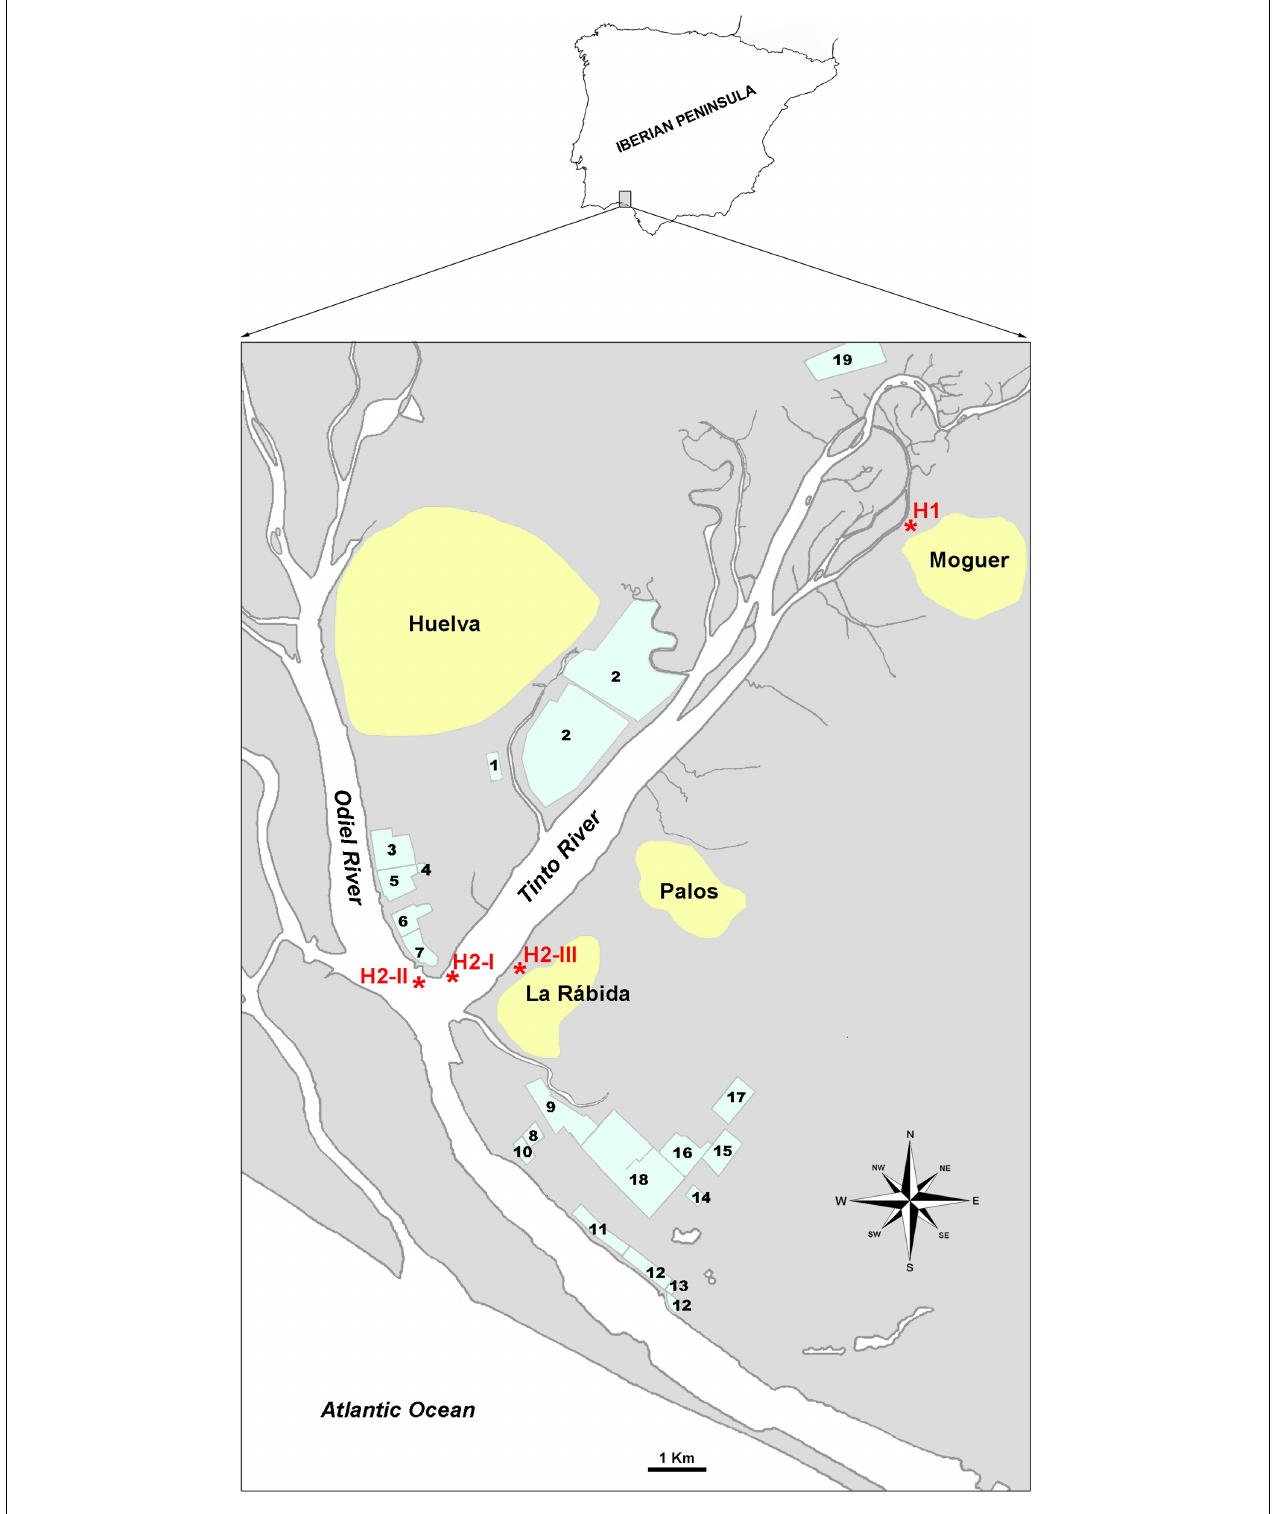
FIGURE 1 | Situation map of sampling sites. Sampling points are labeled as H1 and H2-I, H2-II and H2-III. 1. WWTP of Huelva. 2. Phosphogypsum deposits. 3., 6., and 15. Fertilizers plants. 4. Liquefied gases plant. 5. Copper metallurgy plant. 7. Thermic energy plant. 8. Chemicals production plant. 9. Hydrocarbons storage. 10. Petroleum coque storage. 11. Natural gas plant. 12. Petrochemical products storage. 13. Palm oil refinery. 14. Biodiesel plant. Pharmaceuticals and food supplements plant. 17. Pigments plant. 18. Oil refinery. 19. Biomass thermic plant (old cellulose plant).